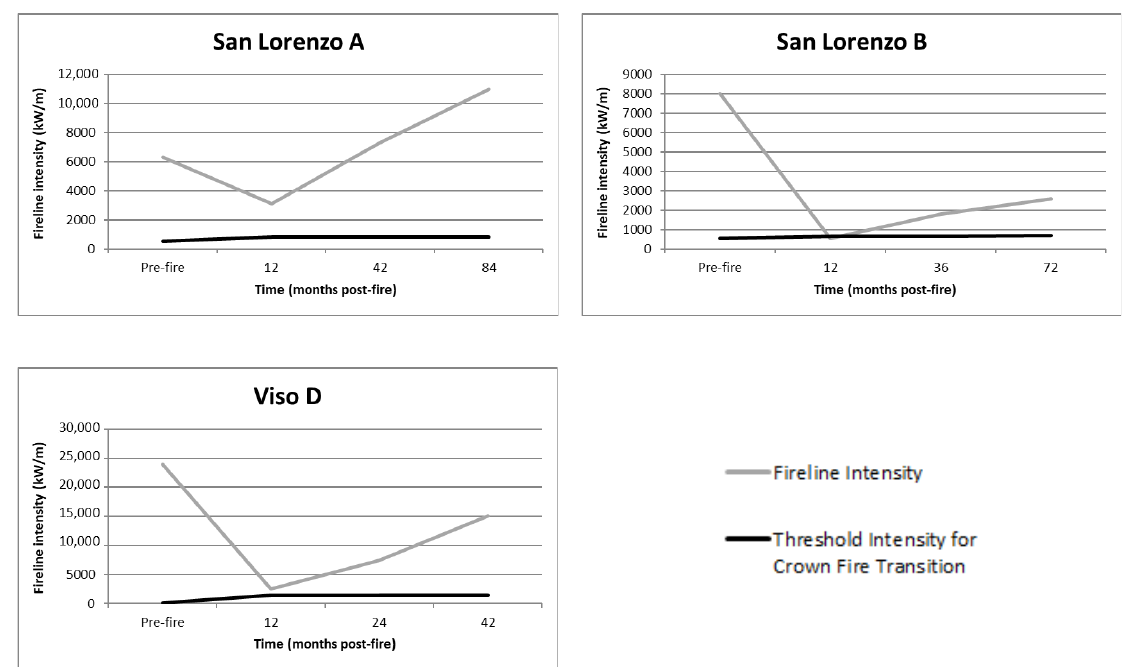
Figure 7. Fire-line intensity versus threshold intensity for crown fire transition in Group D (San Lorenzo A, San Lorenzo B, and Viso D). If the fire intensity is higher than threshold intensity, surface fire will be sufficient to ignite tree